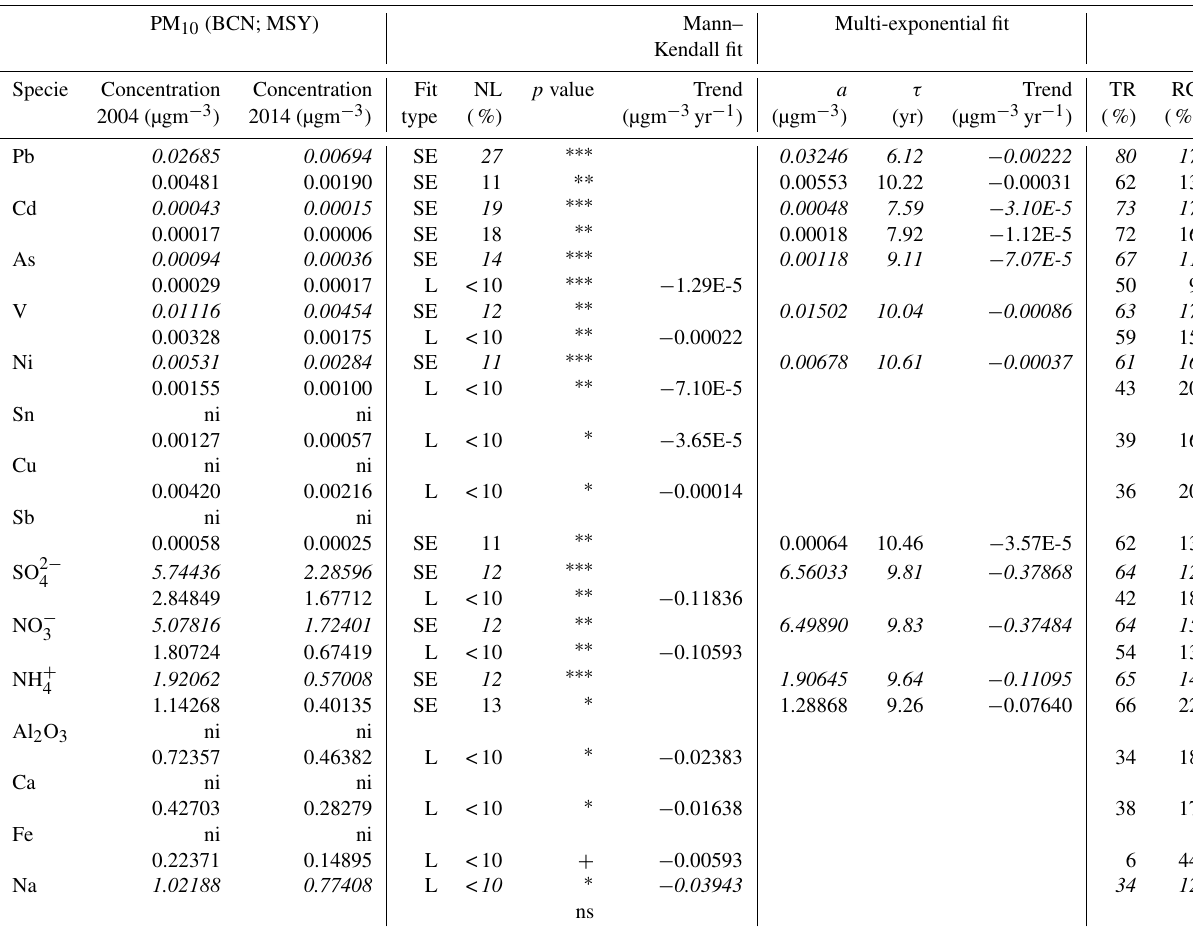
Table 2. Mann–Kendall and multi-exponential trends of different chemical species in PM 10 at BCN (italic) and MSY. Type of trend: linear (L), single exponential (SE), double exponential (DE); a (µgm − 3 ) and τ (yr) are the constants and the characteristic times, respectively, of the exponential data fittings; NL (%) is the nonlinearity; TR (%) is the total reduction; RC (%) is the residual component; ns denotes not statistically significant; ni denotes not included. Significance of the trends: ∗∗∗ ( p value<0.001), ∗∗ ( p value<0.01), ∗ ( p value<0.05), + ( p